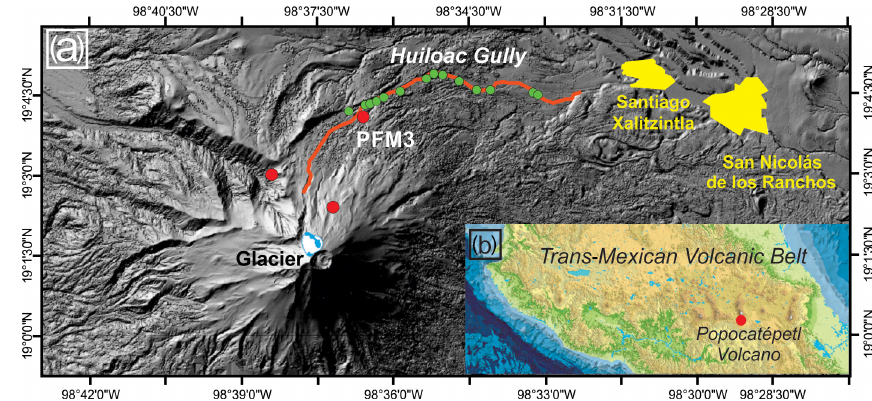
Figure 1. (a) Localization of Popocatépetl volcano in the Trans-Mexican Volcanic Belt. (b) Popocatépetl volcano. The orange line represents the 2001 lahar deposit distribution. Red circles are CENAPRED geophone locations. Green circles indicate the location of stratigraphic sections collected by Capra et al. (2004).